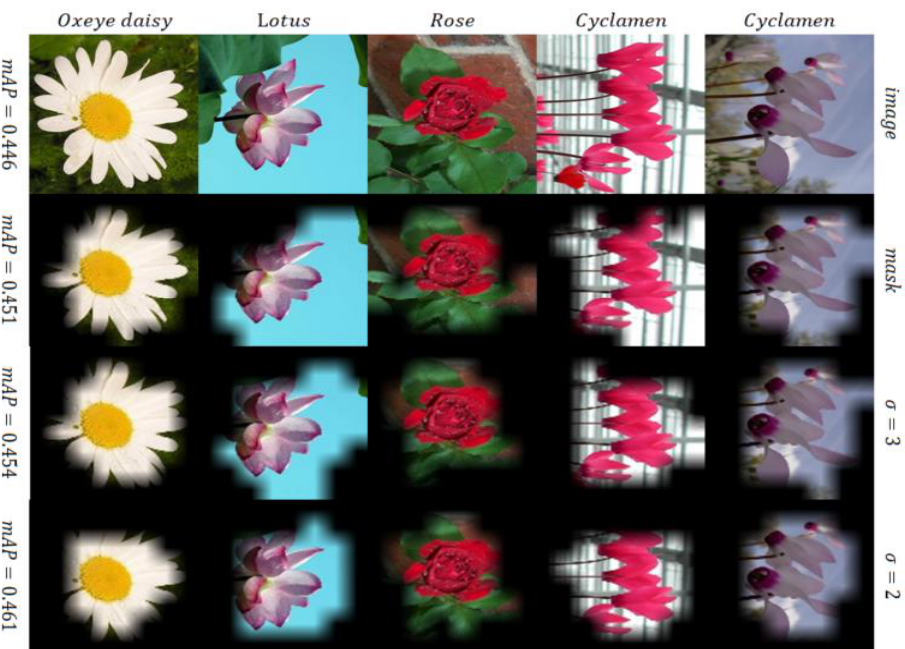
Figure 6. Regional masking on the Flowers dataset. Table 3. Effect of channel expansion on the Flowers dataset (mAP for top 5). GMP = global max